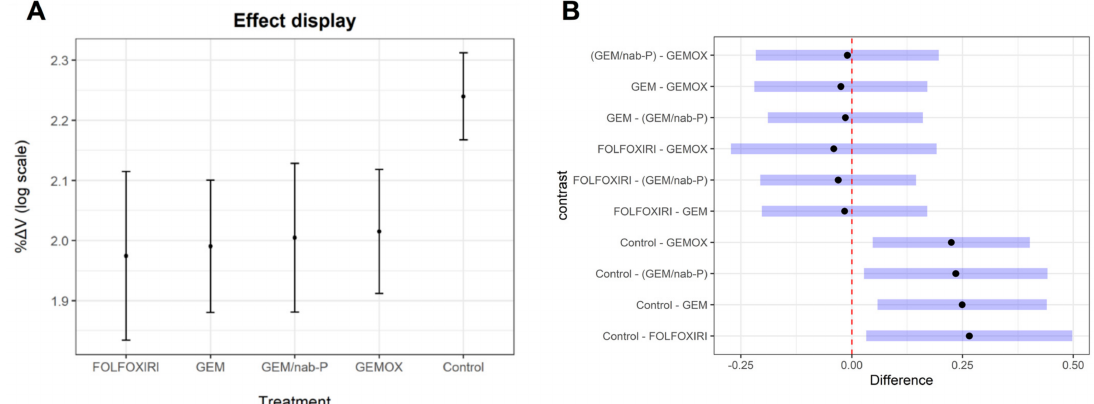
Figure 2. Effects of chemotherapy drugs in the linear mixed effect model. ( A ) Effect displays. The treatments are displayed on the x-axis. Dots identify the fixed effect values of % ∆ V estimated by LMM. The bars are the 95% CI of fixed values. ( B ) Post-hoc test results. Pairwise comparisons are on the y-axis, and the differences of marginal means between treatments are on the x-axis. Blue bars represent the 95% CI of means differences. The dashed line is a difference equal to zero between